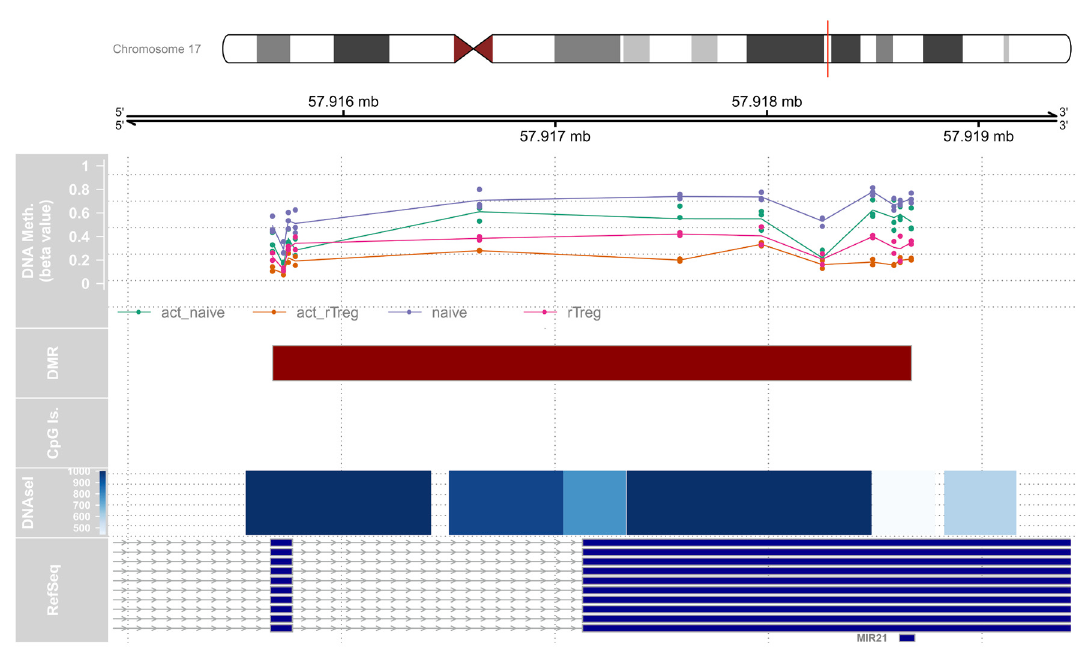
Figure 11. The Gviz package provides extensive functionality for customising plots of genomic regions. This plot shows the top ranked DMR identified by the DMRcate